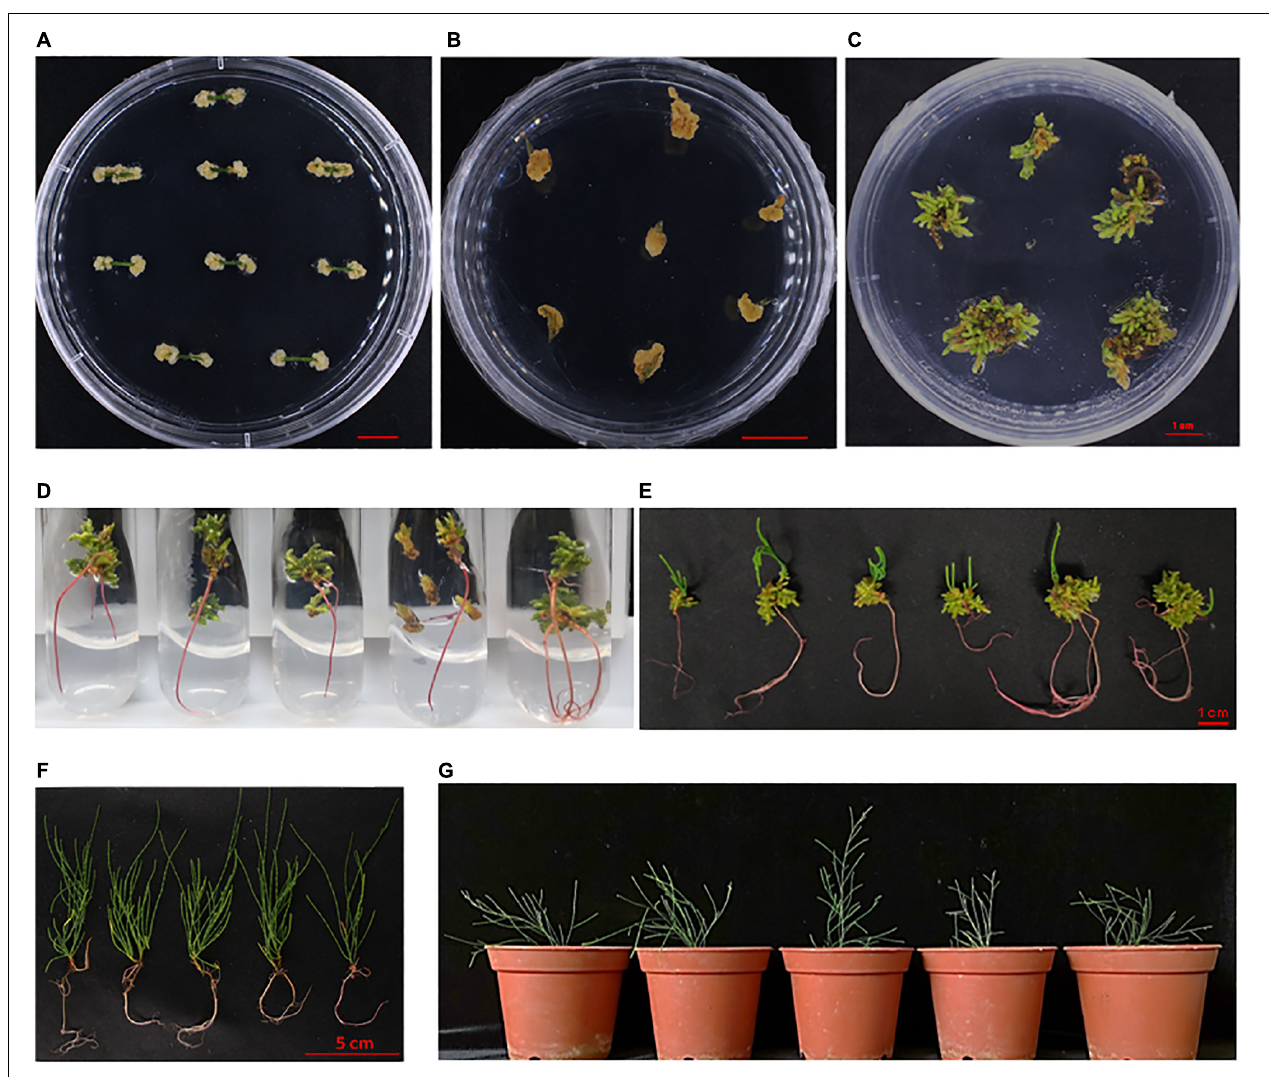
FIGURE 4 | Efficient regenerating system for Casuarina equisetifolia using the stem as explant. (A) Callus induction in the C4 medium. (B) Callus proliferation in the C5 medium. (C) Bud induction in the B14 medium. (D) Root induction in the R1 medium. (E) Root regeneration of adventitious bud. (F) Seedlings using suitable regenerating system. (G) Transplantation of regenerated